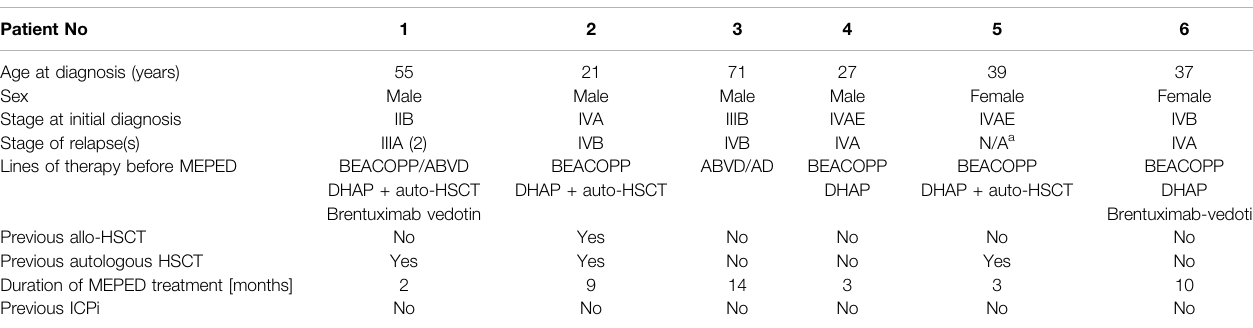
TABLE 2 | Summary of patient characteristics; patients 4 – 6 have already been published in Ugocsai et al. (2016). Patient